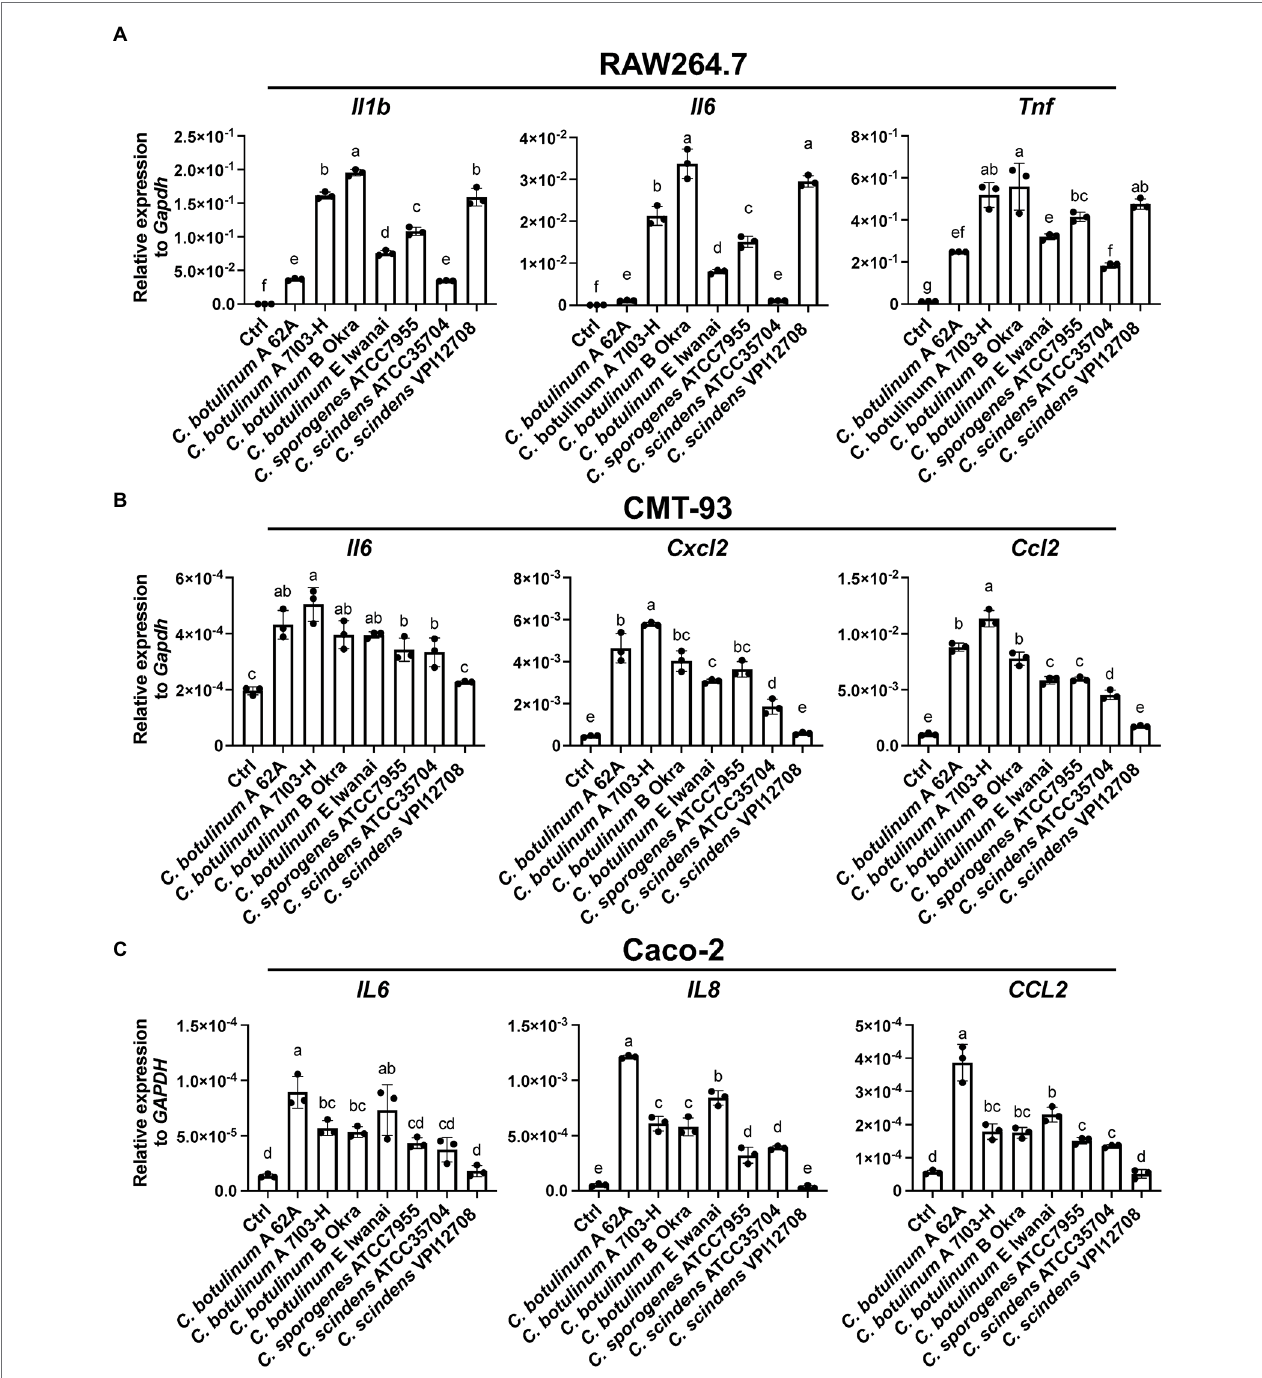
FIGURE 2 | Real-time quantitative PCR (RT-qPCR) analysis of cytokine gene induction by clostridial MVs in (A) RAW264.7, (B) CMT-93, and (C) Caco-2 cells. Cells were treated with 10 (A) or 50 (B,C) μ g/ml MVs for 6 h. Ctrl, control. Means that do not share a letter are significantly different ( p < 0.05). Error bars indicate SD. n = 3, a one-way ANOVA with Tukey’s multiple comparisons post hoc test. Data are representative of two independent